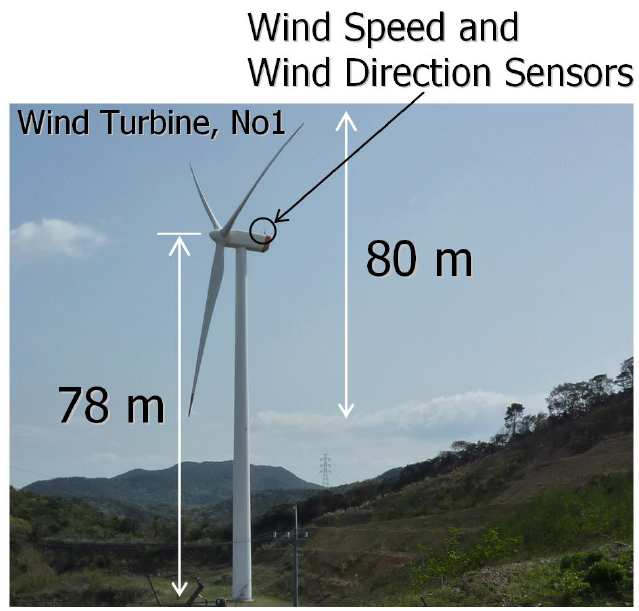
Figure 2. Photo of the No. 1 wind turbine showing specifications of the wind turbines.